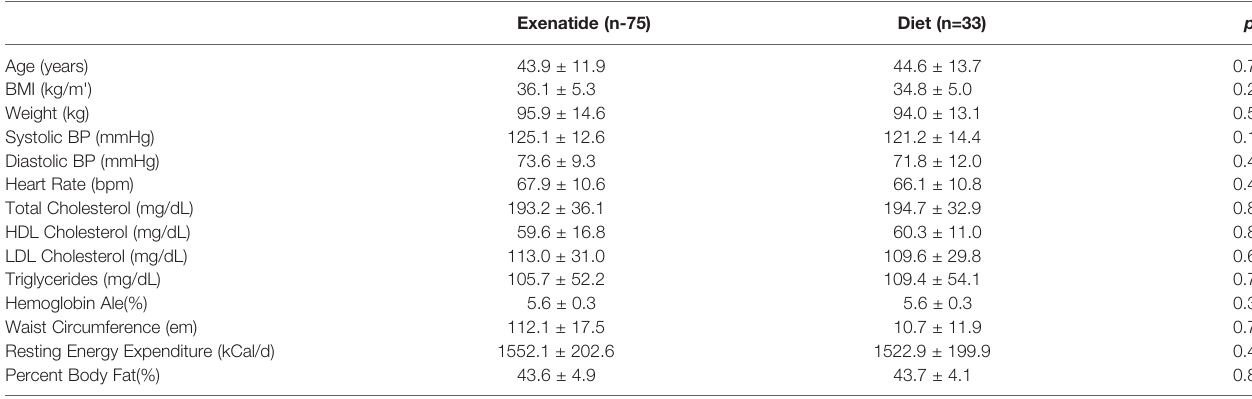
TABLE 1 | Baseline characteristics of the study